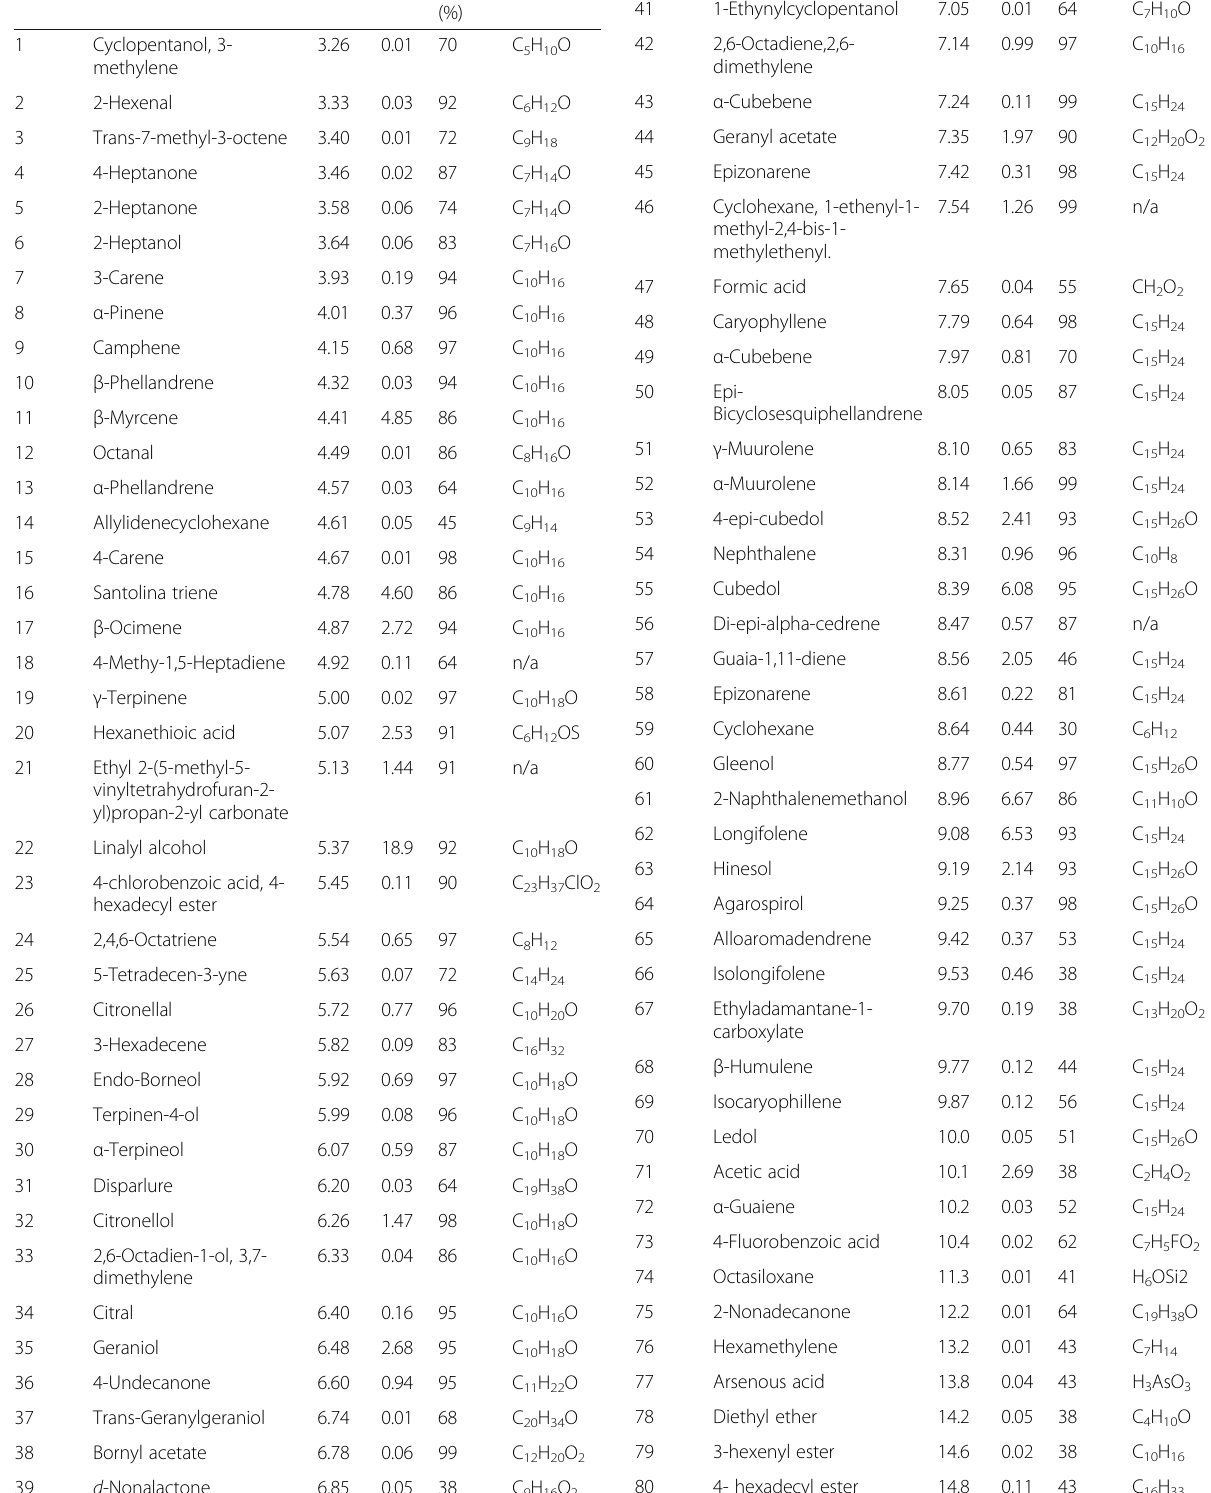
Table 2 Chemical compounds of Cymbopogon validis leaf Peak number